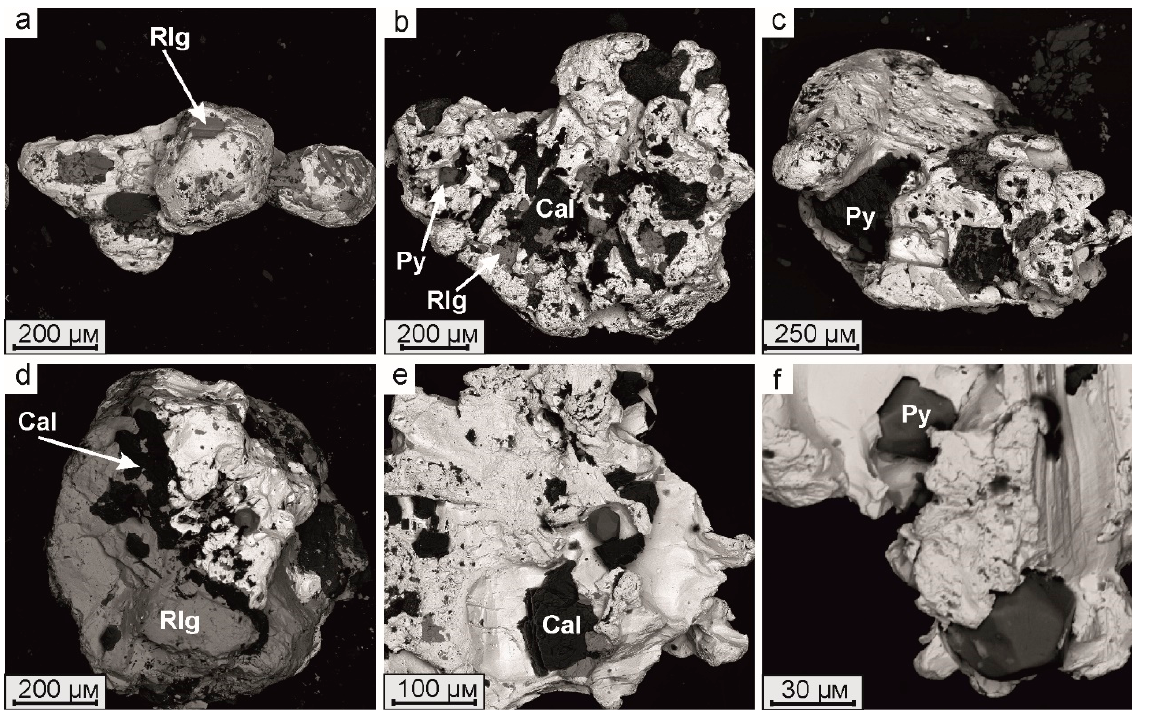
Figure 7. Optical photo of the native gold in realgar-orpiment breccias of the Vorontsovskoe deposit: ( a ) gold grain and pyrite (Py) in calcite; ( b ) the grain of gold in realgar-orpiment (Rlg + Orp) breccia cement; ( c ) gold in brecciated calcite marble; Cal + Rlg—the fine-crystalline calcite and realgar.